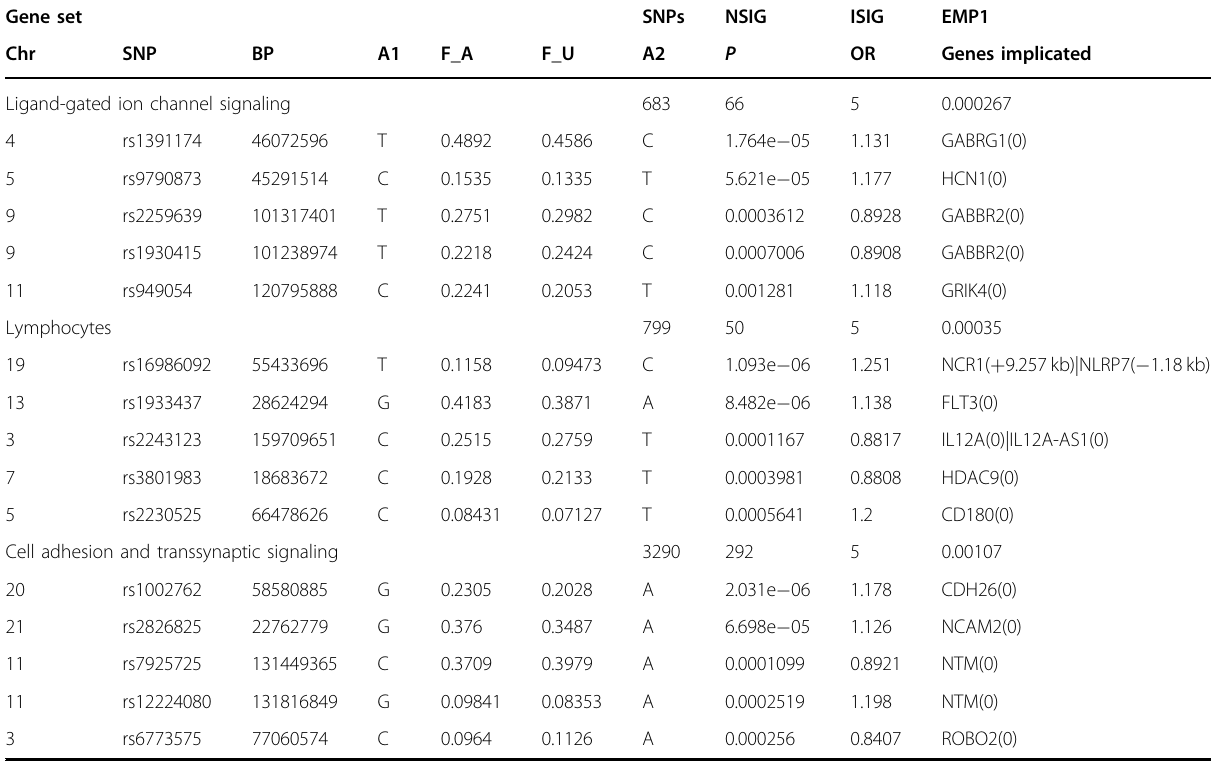
Three pathways achieved signi fi cance. Association statistics for the top fi ve SNPs driving the signal in each set are also shown. NSIG is the number of SNPs crossing the nominal signi fi cance threshold. EMP1 is the empirical p -value attained by the tested gene set. P is the p -value of the original single-marker association, OR is the respective odds ratio. A1 is the minor allele and A2 the major allele. F_A and F_U are the frequencies of the minor allele in case and control samples,